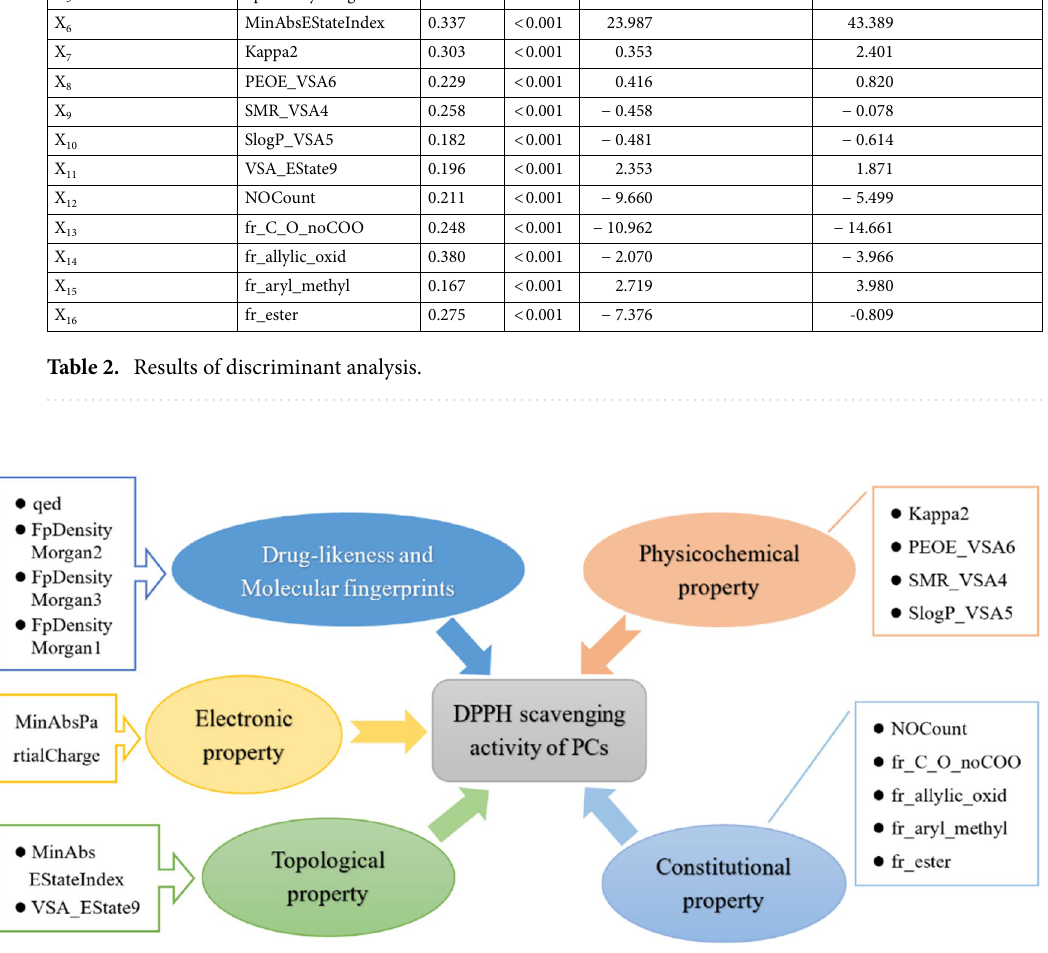
Figure 1. Relationship between antioxidant activity and molecular descriptors of PCs.